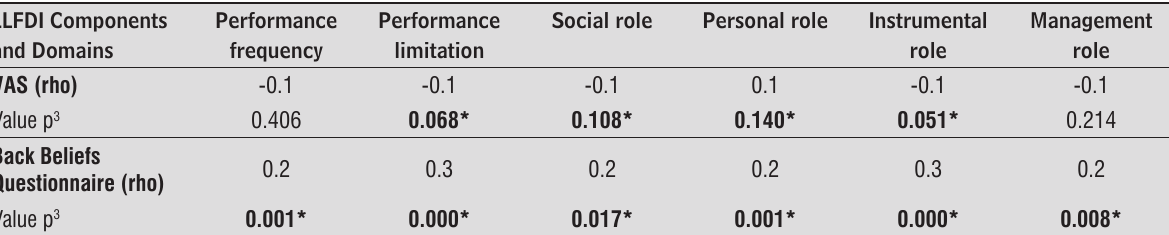
Table 3 - Bivariate analysis of factors associated with LLFDI dimensions and areas LLFDI Components